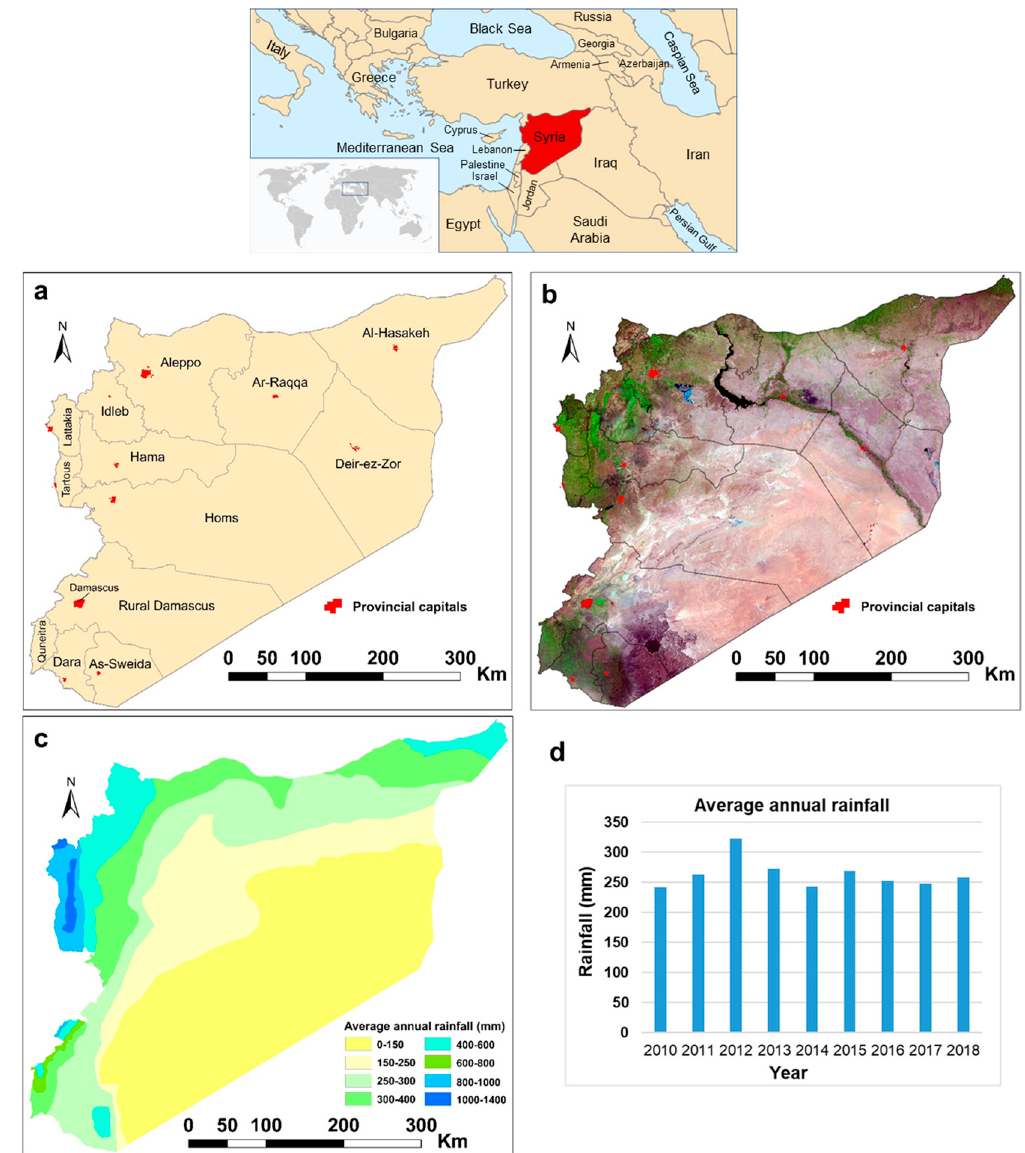
Figure 1. Map of Syria, the 14-governorates administrative divisions ( a ), false colors composite of Landsat 8 OLI image of 2018 (band 6-5-4 as RGB) ( b ), spatial pattern of average yearly rainfall adapted from [67] ( c ), and average annual precipitation in Syria between 2010 and 2018 adapted from [67,68] ( d ). 2.2. Development Stages of Influence and Control in Syria from the Outbreak of the Conflict in 2011 until